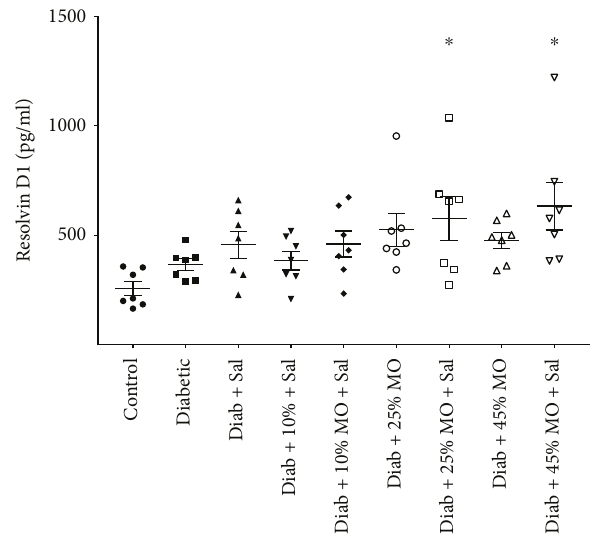
Figure 1: Scatter plot of serum resolvin D1 levels. E ff ect of menhaden oil concentration with or without salsalate on serum levels of resolvin D1 in type 2 diabetic rats are presented. Serum levels are presented as mean ± SEM and are in pg/ml serum. Each symbol per group represents a di ff erent animal, n = 7 per condition. ∗ P < 0 05 compared to control